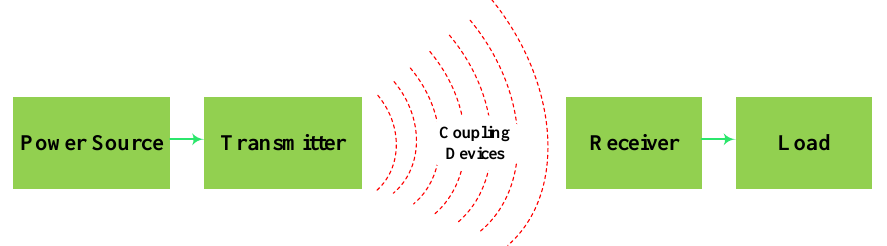
Figure 2. Schematic block diagram of the WPT